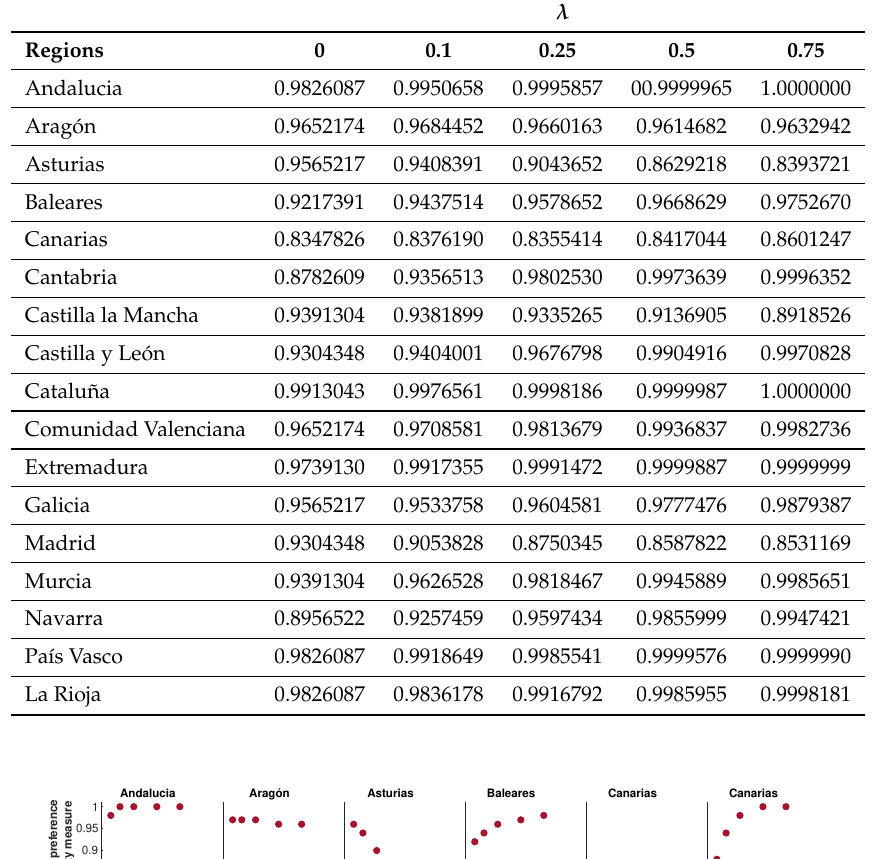
Table A3. Global stability measures for Spaniards’ preferences attending to different regions and several values of λ for Question 1.